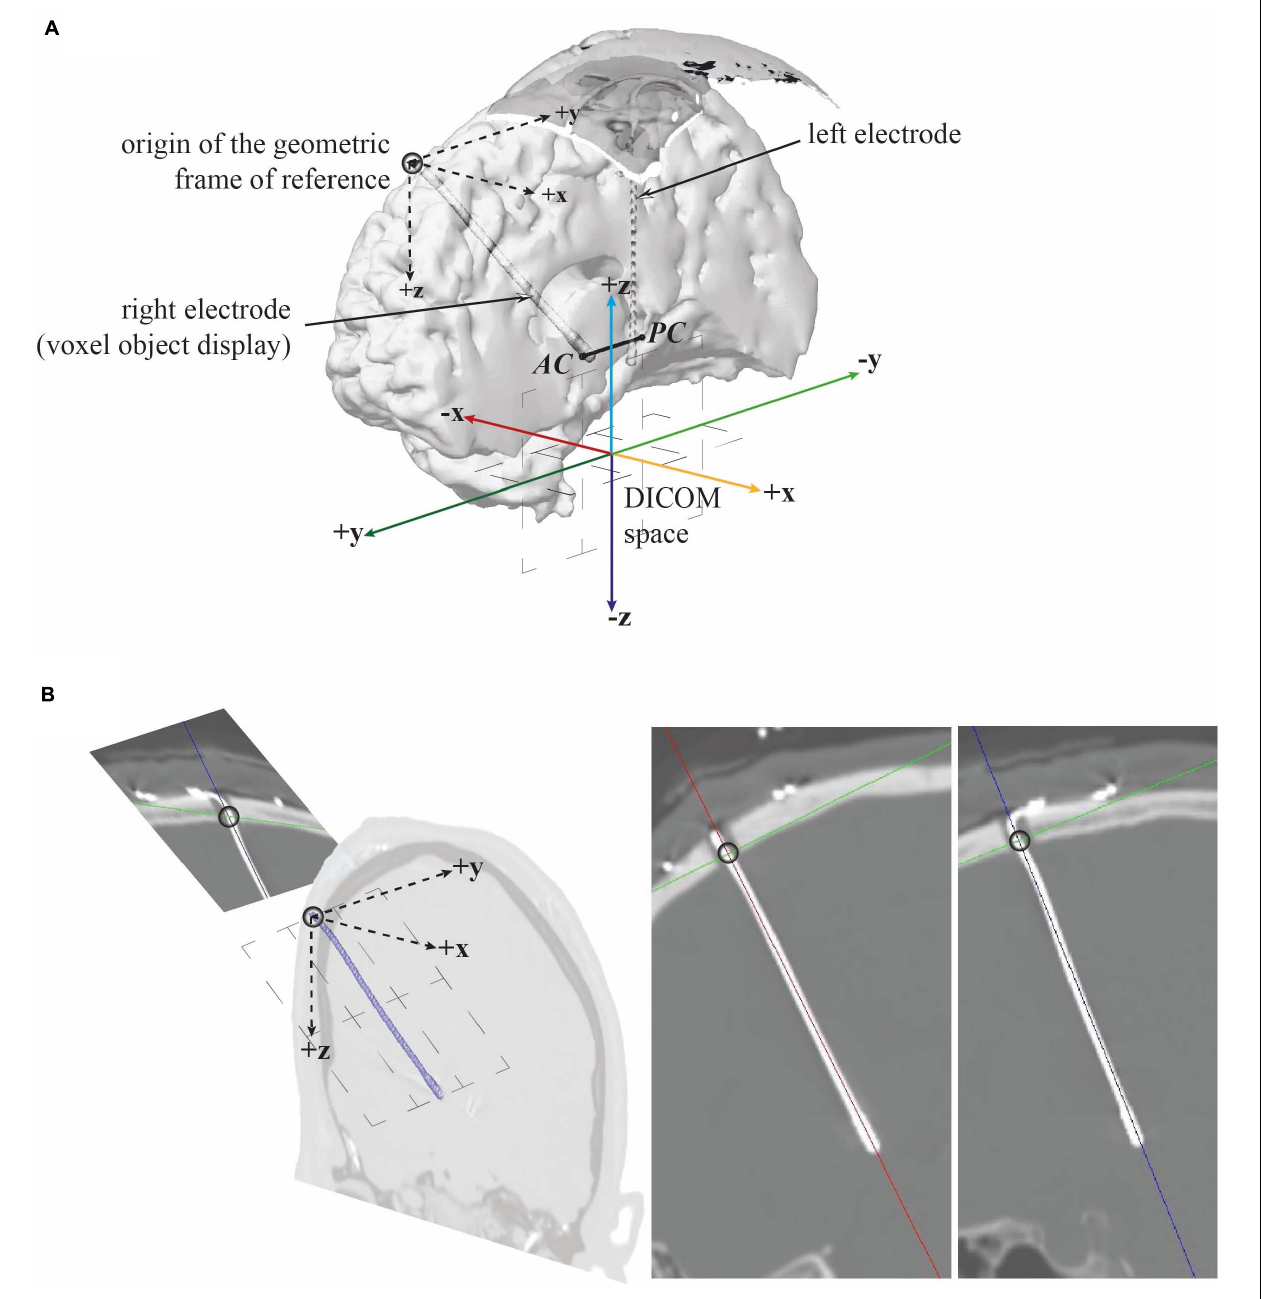
FIGURE 4 | Geometrical frame of reference. (A) Antero-lateral left view of the right hemisphere showing the electrode and the geometrical frame of reference [the anterior commissure-posterior commissure (ACPC) line is given for information]. (B) Reconstructed CT-scan slice, pseudo sagittal, pseudo coronal, and pseudo sagittal (zoom in, from left to right) along the right electrode showing the proximal point (black circle) that served as origin of the geometric frame of reference.